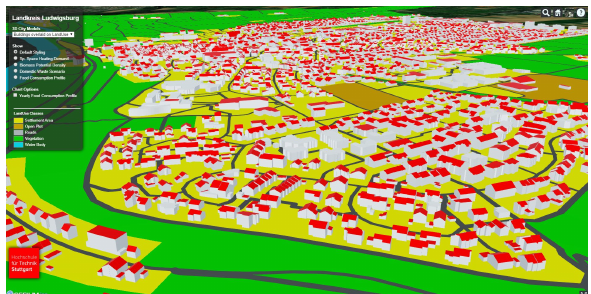
Figure 13. Temporal food consumption profile for County of